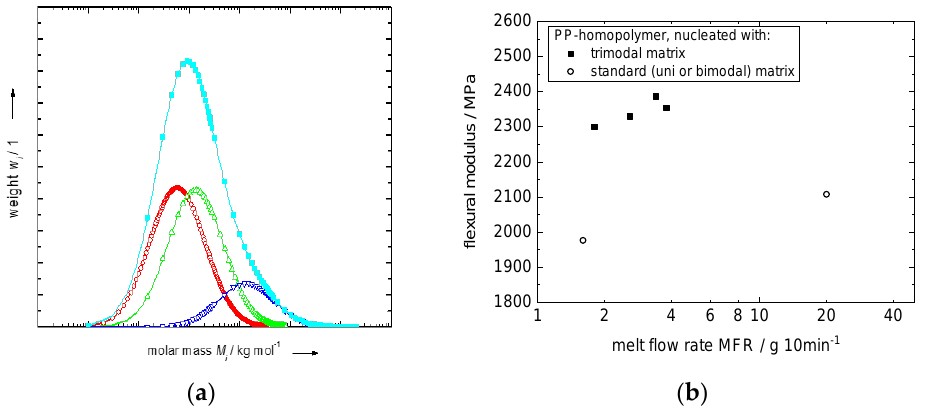
Figure 13. ( a ) Schematic representation of the MWD of a trimodal PP homopolymer (curves with different colour represent the different fractions) and ( b ) flexural modulus over MFR for selected tri-modal and conventional PP homopolymers of medium flowability (data from [105]).